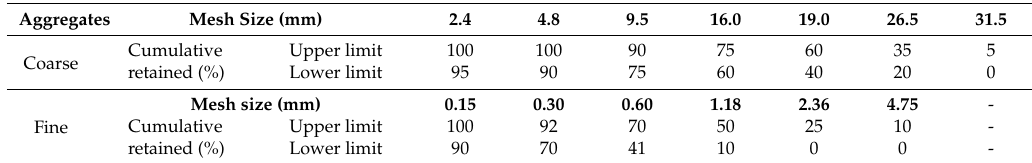
Table 1. The gradation of coarse and fine aggregates.